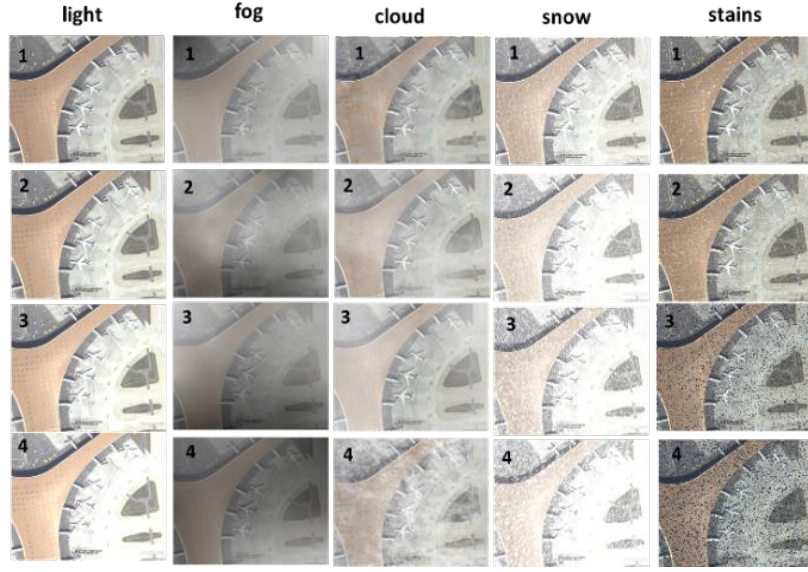
Figure 9. Comparison of test results on RSOD dataset.